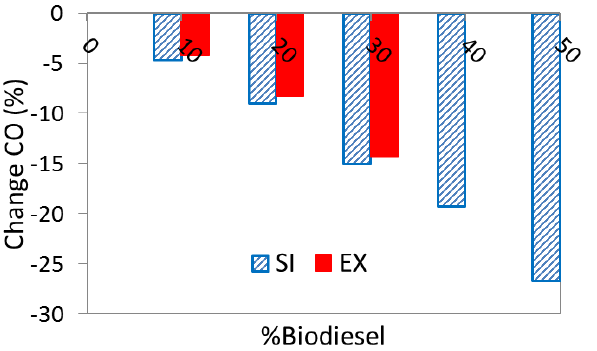
Figure 12. Relationship between CO emissions and biodiesel blending ratio of simulation (SI) and experiment (EX).